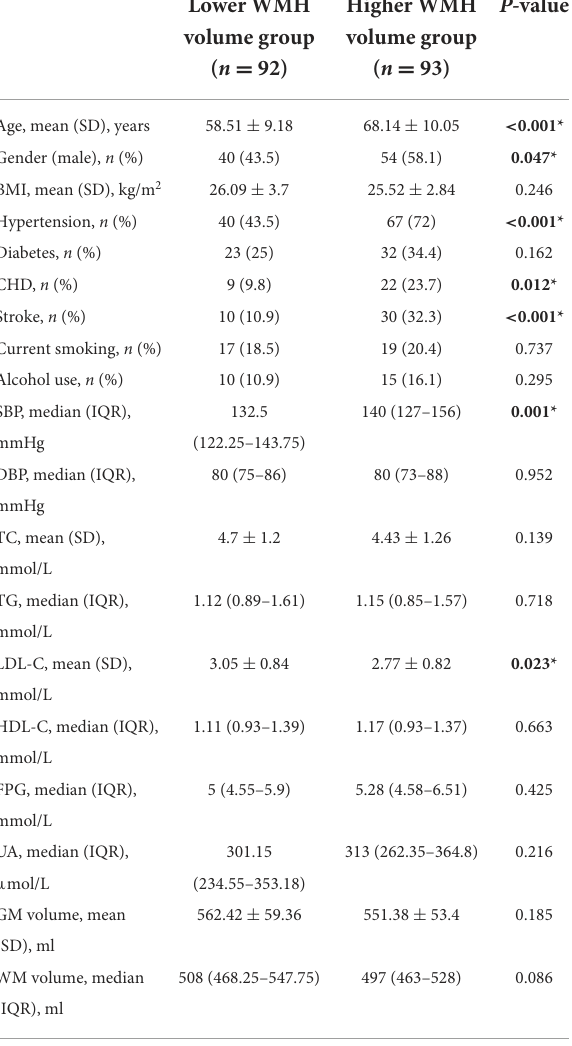
TABLE 2 Comparison of the retinal thickness in different subfields between the lower white matter hyperintensity volume group and the higher white matter hyperintensity volume